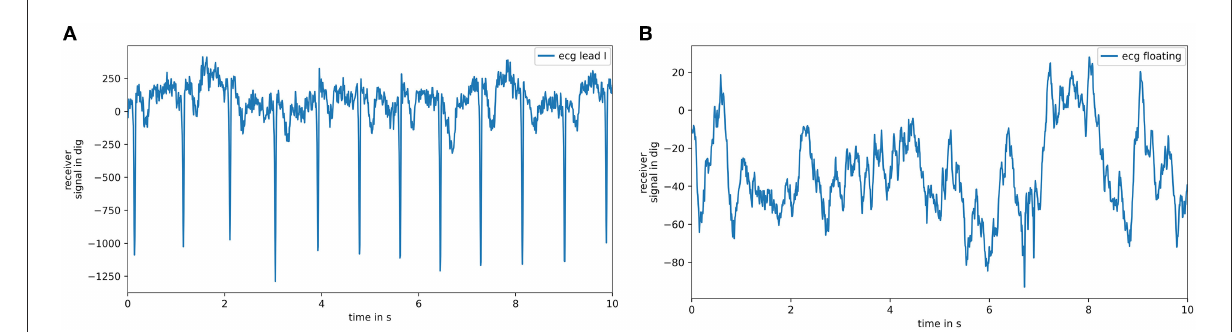
FIGURE7 Excerpts from raw measurements of the analog ECG front-end of the MAXREFDES101# device: touching the electrode at the front closes the traditional lead I and results in visible, distinct ECG pulses (A) ; for a floating electrode, the pulses vanish into the noise floor and the heart beat can only be guessed (B)